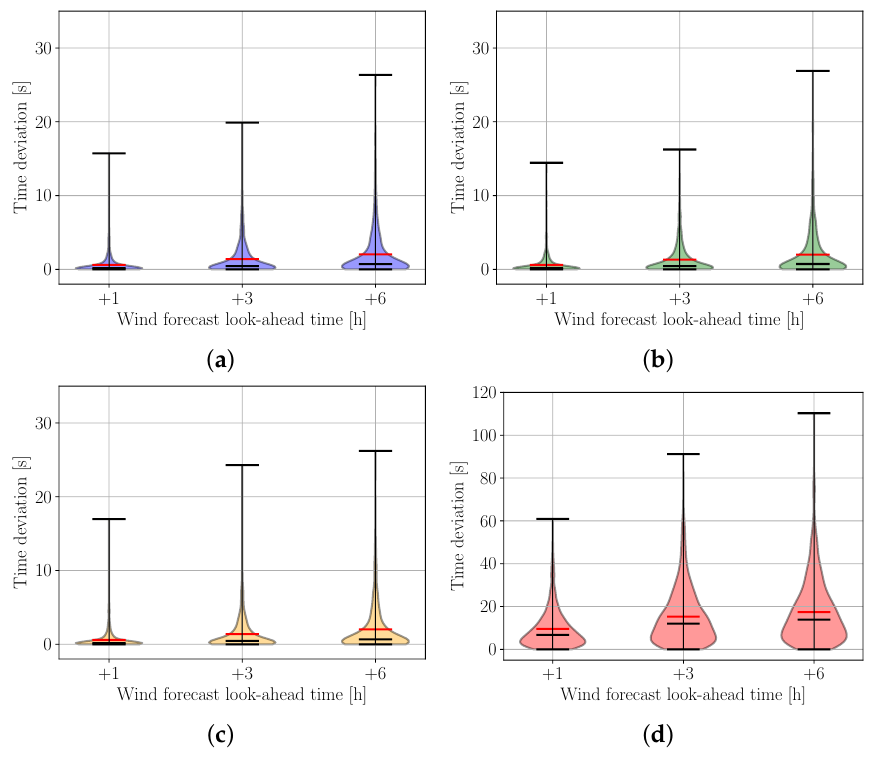
Figure 5. Time deviation at the metering/merging fix. ( a ) NMPC. ( b ) SbNMPC. ( c ) AsNMPC. ( d ) Open-loop.